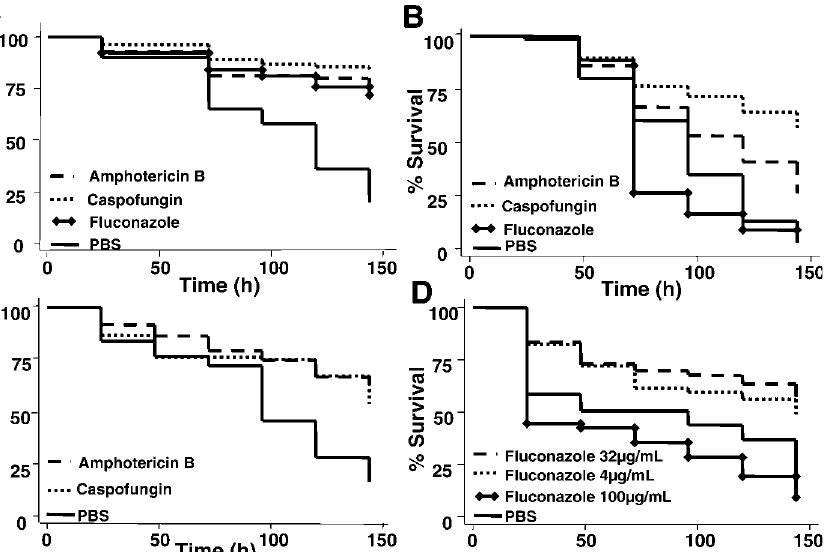
Figure 6. Antifungals Prolong the Survival of C. elegans glp-4;sek-1 Nematodes Infected by Candida spp. and Evaluation of Antifungals in the C. elegans Assay Allows the Concomitant Evaluation of Toxicity Nematodes were infected with Candida for 2 h and then moved to pathogen-free liquid media in the presence of antifungals or PBS. Dead worms were counted and removed daily. (A) C. albicans strain MLR6. p , 0.0001 for caspofungin (8 l g/ml), amphotericin B (16 l g/ml), and fluconazole (32 l g/ml). (B) C. krusei strain ATCC#6258. p , 0.0001 for caspofungin (8 l g/ml) and amphotericin B (16 l g/ml). (C) C. parapsilosis ATCC#20019. p , 0.0001 for caspofungin (8 l g/ml), amphotericin B (16 l g/ml), and fluconazole (32 l g/ml). (D) C. parapsilosis ATCC#20019. The p- values are 0.0001 for 4 l g/mL, , 0.0001 for 32 l g/mL, 0.01 for 100 l g/mL ( ; 65 nematodes/group).